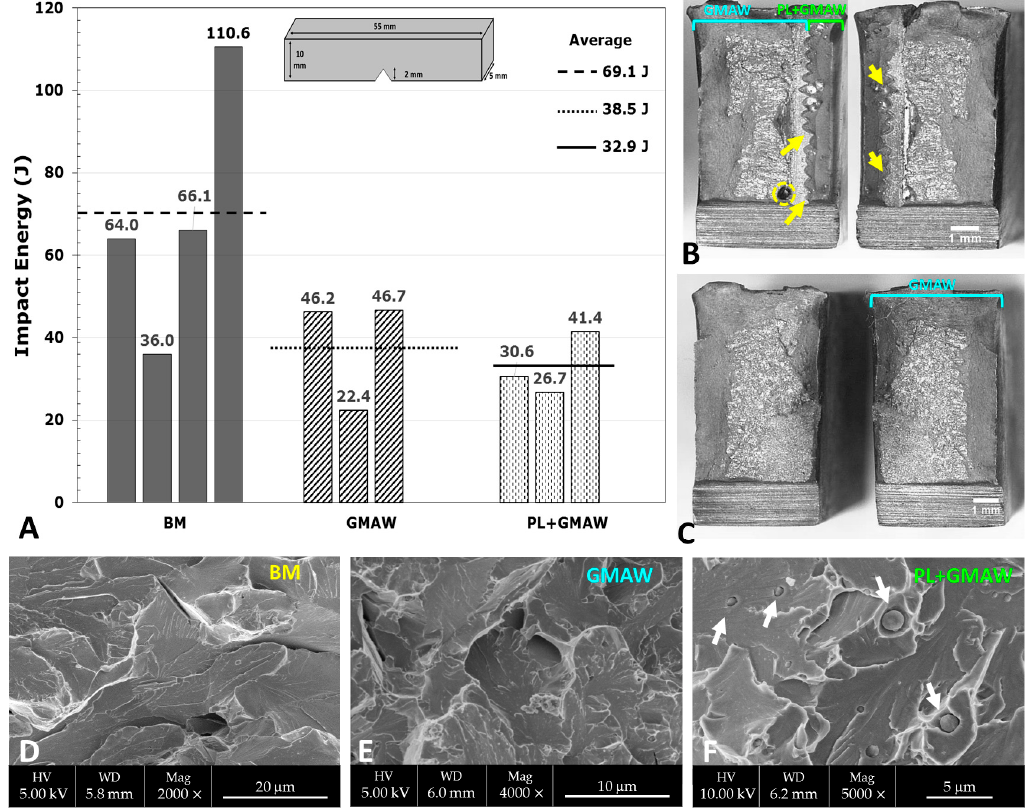
Figure 7. Results of the Charpy test at − 50 °C ( A ) and the fracture surfaces of the PL + GMAW ( B ) and GMAW ( C ). SEM micrographs of the BM ( D ), GMAW ( E ), and PL + GMAW ( F ).